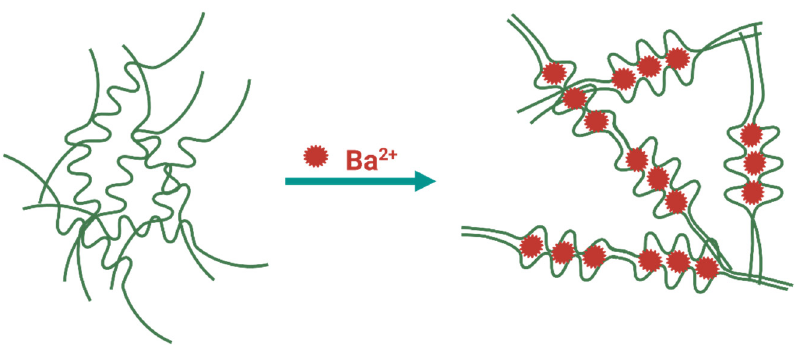
Figure 5. Schematic representation of ion crosslinking of alginate gel by the “egg box” model. Figure created with BioRender.com .